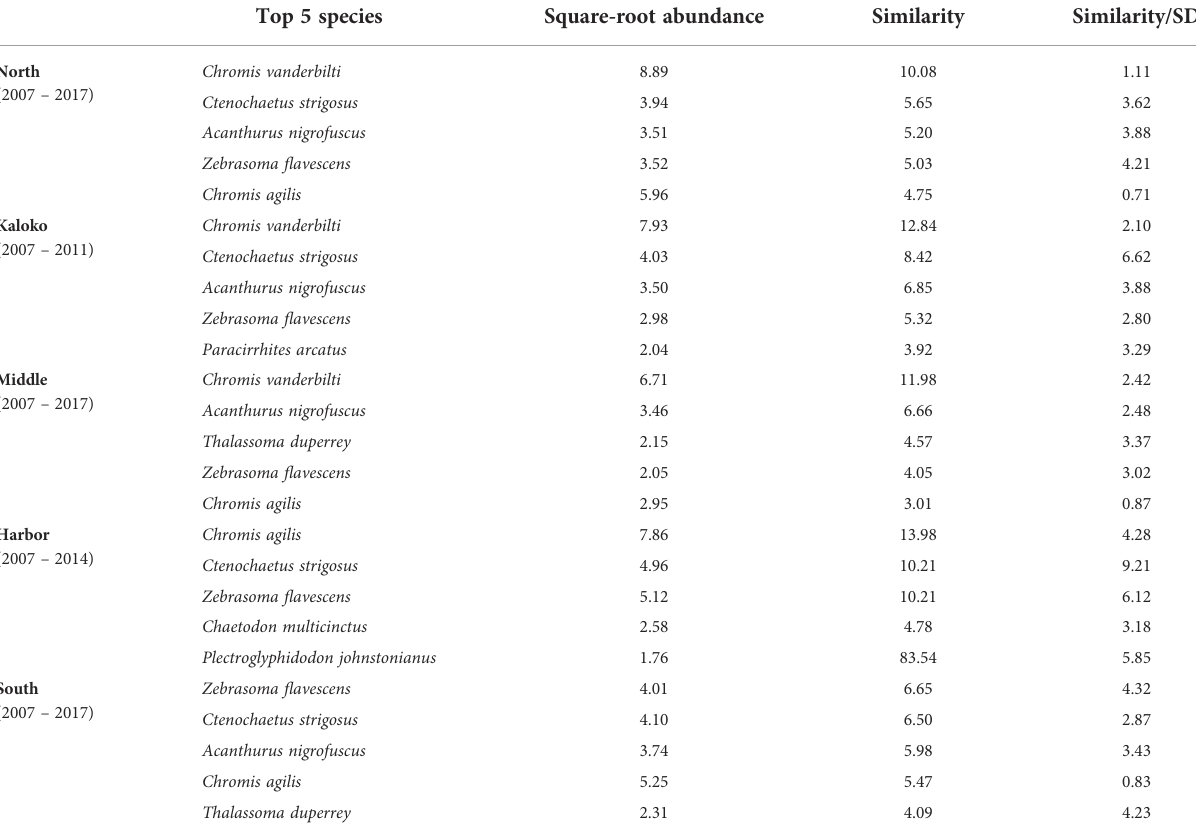
TABLE 2 Results of SIMPER analysis showing the top fi ve species that were consistently present in high abundance in each region of KAHO in “ typical ” years identi fi ed by